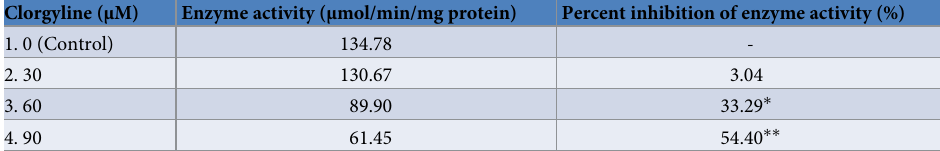
(1.) Control devoid of inhibitor (2.) The adult F . gigantica worms treated with clorgyline at 30 μ M. (3.) 60 μ M